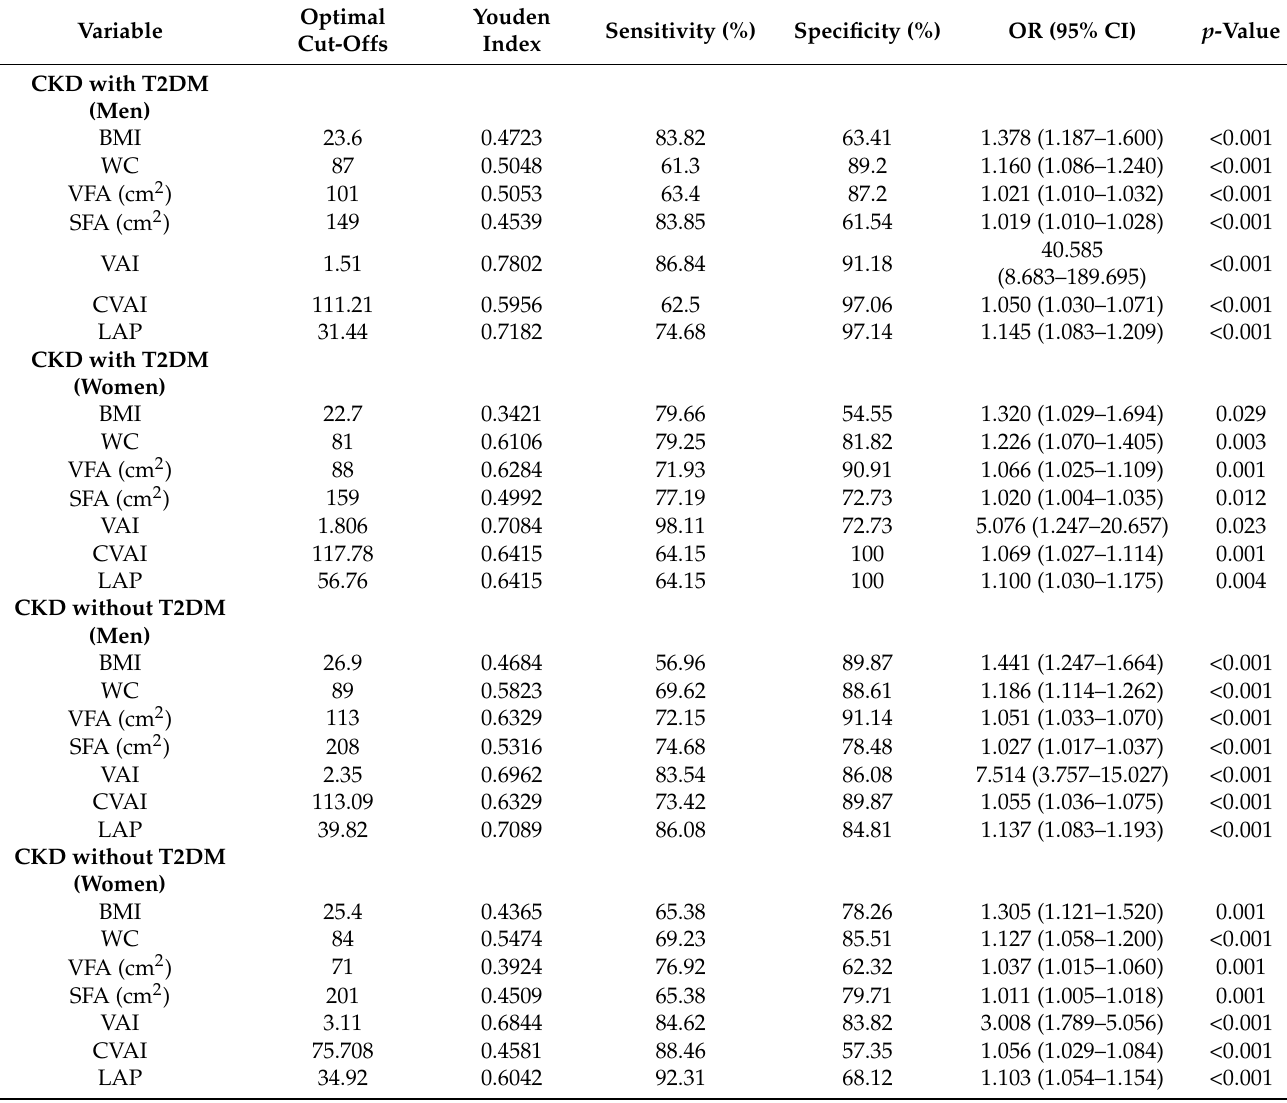
Table 3. Predictive value of seven obesity- and lipid-related indices in China (2020) criteria and multivariate logistic regression